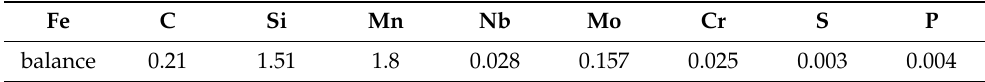
Table 1. The composition of the microalloyed steel (in weight